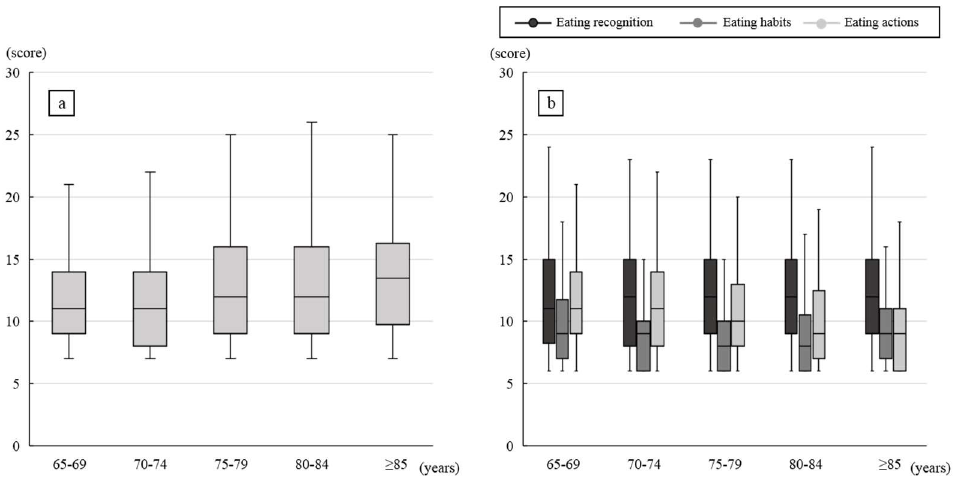
Figure 1. Age-dependent change in symptoms of oral frailty and each eating behaviors ( a ): symptoms of oral frailty, ( b ): eating behaviors. The box plot indicates the median with ± 75 / 25 quartile and minimum / maximum values.